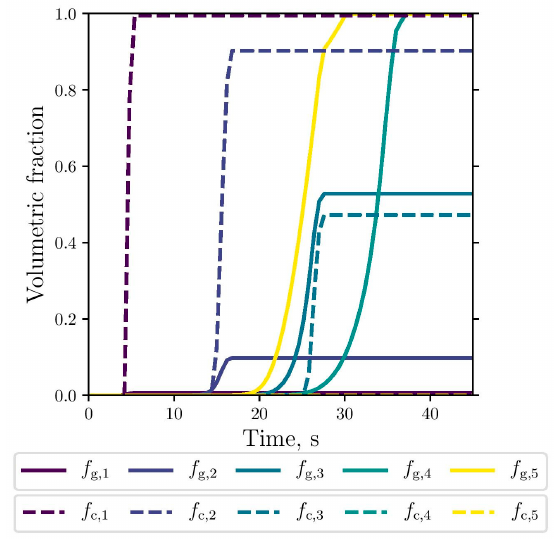
Figure 9. Simulated gray (continuous lines) and white (dashed lines) eutectic evolution at the selected points.